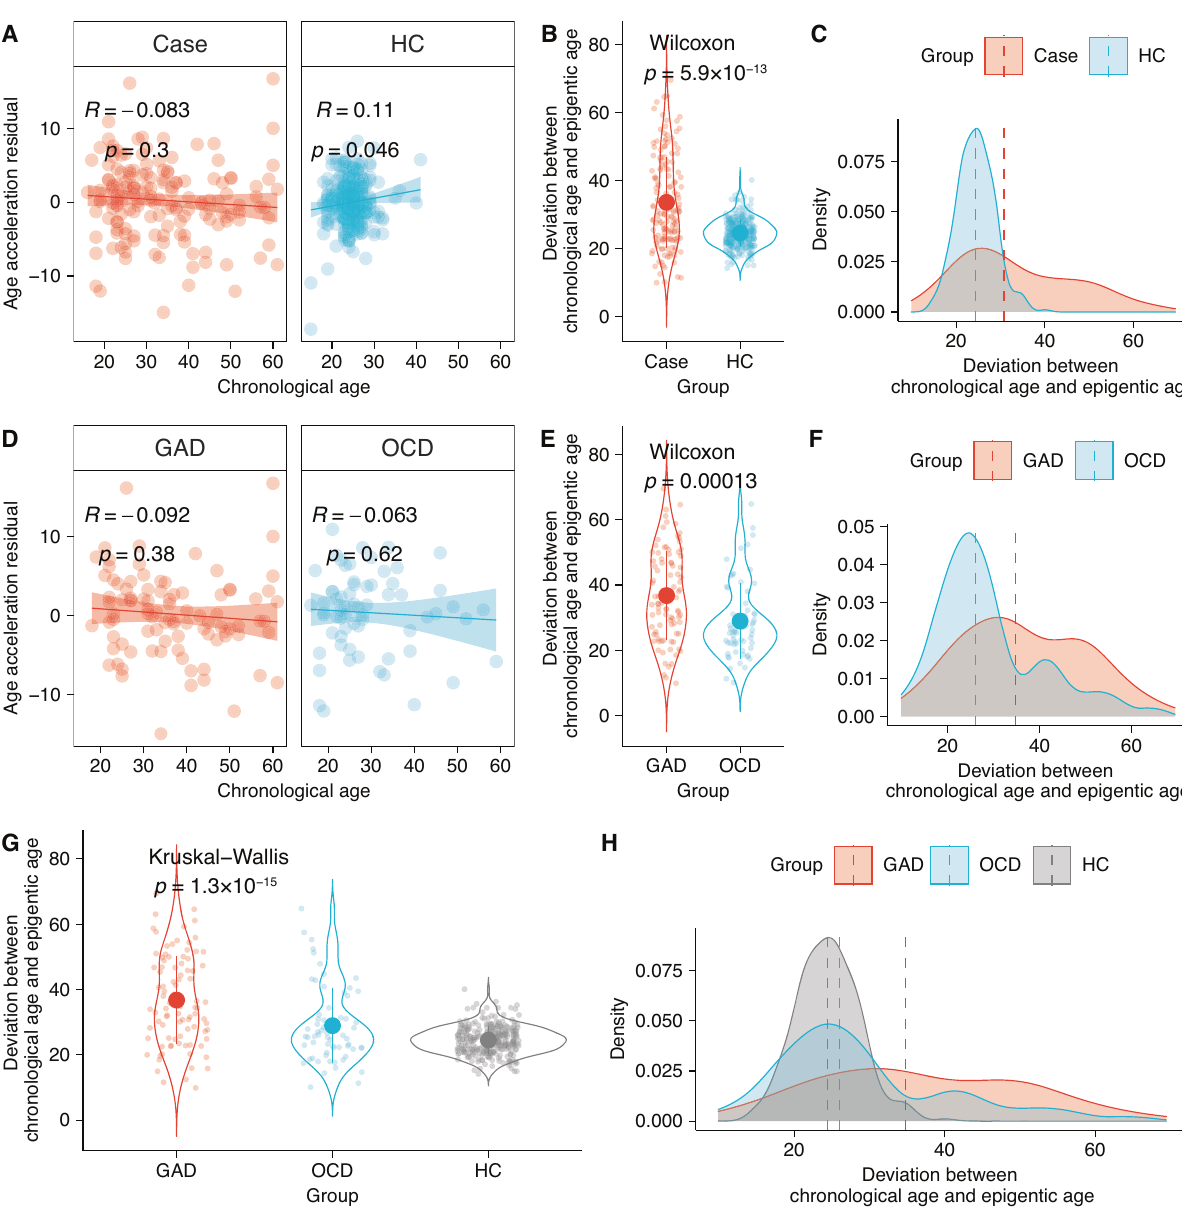
Fig. 3 Estimation of the epigenetic clock (age acceleration difference). A Pearson correlation in the case-control study revealed a signi fi cant correlation ( p < 0.05) between chronological age and epigenetic age (age acceleration residual) in health control (HC, right panel) and a nonsigni fi cant correlation in cases (GAD and OCD, left panel). B Wilcoxon test indicated a signi fi cant difference of epigenetic-chronological deviation between cases and controls ( p = 5.9 × 10 − 13 ). C Density plot for epigenetic-chronological deviation between cases and controls. D Pearson correlation of chronological age and epigenetic age (age acceleration residual) in GAD (left panel) and OCD (right panel), respectively. E Wilcoxon test indicated a signi fi cant difference of epigenetic-chronological deviation between GAD and OCD ( p = 0.00013). F Density plot for epigenetic-chronological deviation between GAD and OCD. G Kruskal – Wallis test indicated a signi fi cant difference of epigenetic-chronological deviation between GAD, OCD, and HC ( p = 1.3 × 10 − 15 ). H Density plot for the epigenetic-chronological deviation between GAD, OCD, and volume (a neuroimaging biomarker re fl ecting microglia activation during neuroin fl ammation) was elevated in patients with OCD and prevention of the expression interleukin-33 in lipopolysaccharide- induced in fl ammation model attenuated the anxiety-like behavior. We identi fi ed two DMPs cg01334186 and cg09379601 nearby the in fl ammation-related genes PSMB4 and DNASE2 , respectively, were